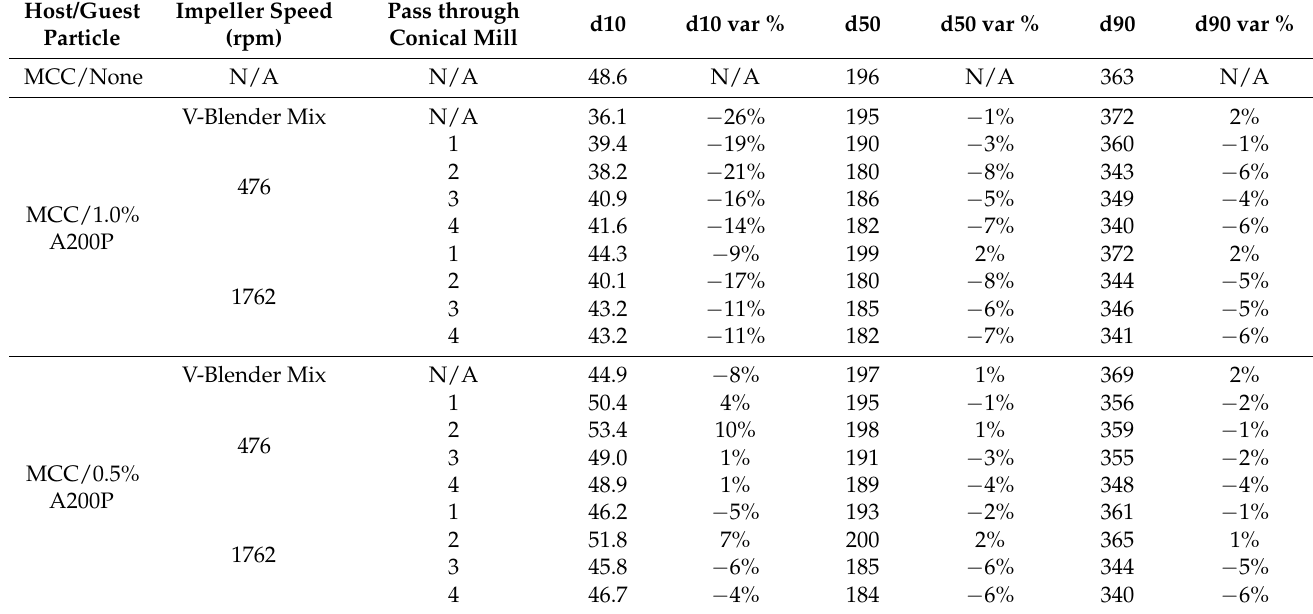
Table 4. MCC particle size distribution results of the continuous mode